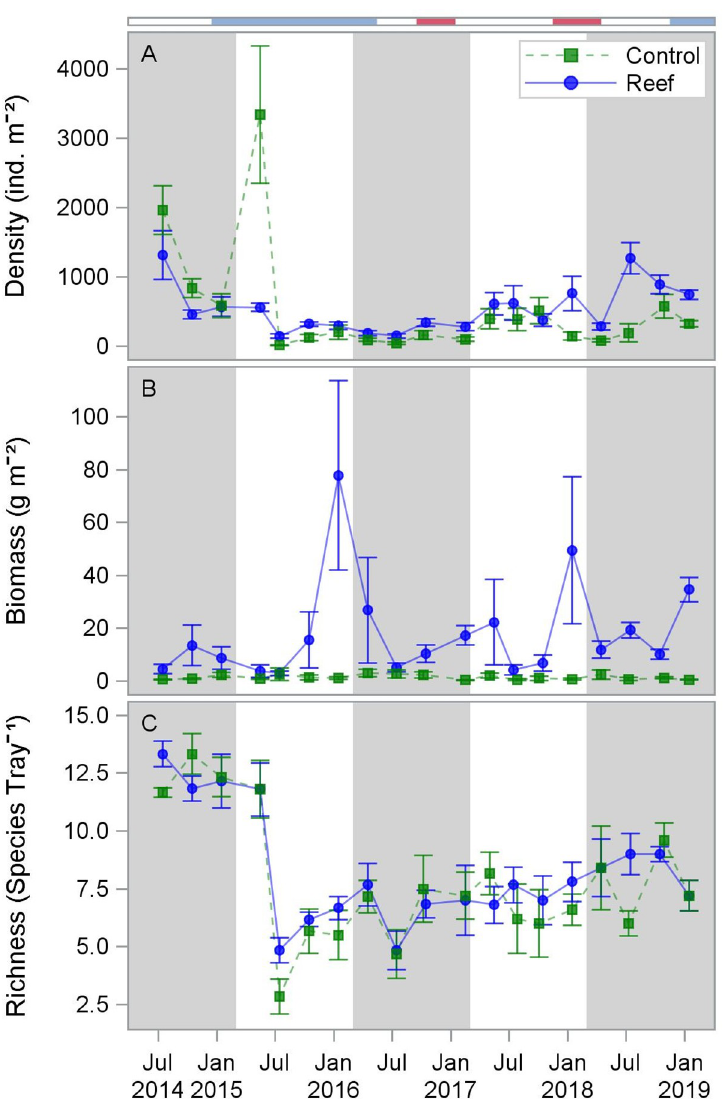
Fig 5. Mean (SE) resident motile fauna density (A), biomass (B), and richness (C) measured at constructed reef and control sites from July 2014-January 2019. Colors on horizontal bar indicate ENSO state: light blue = El Ni ñ o, red = La Ni ñ a.